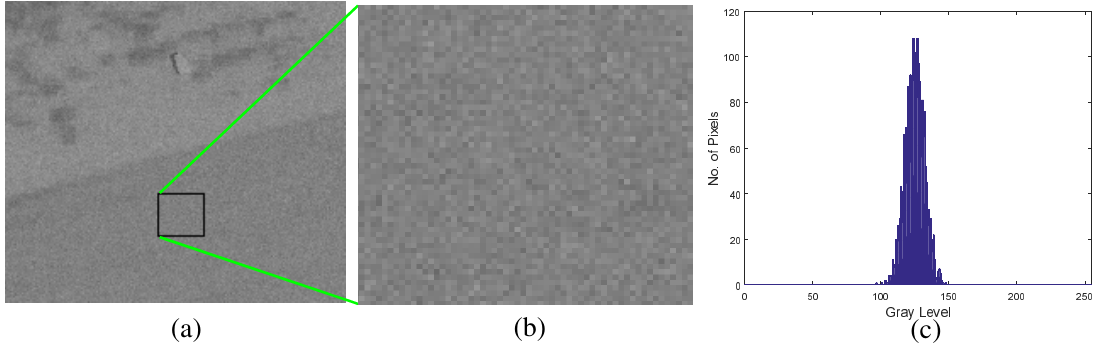
Figure 7. Thermal noise analysis in an infrared image: ( a ) test sample image; ( b ) enlarged image of background region; ( c ) noise distribution.